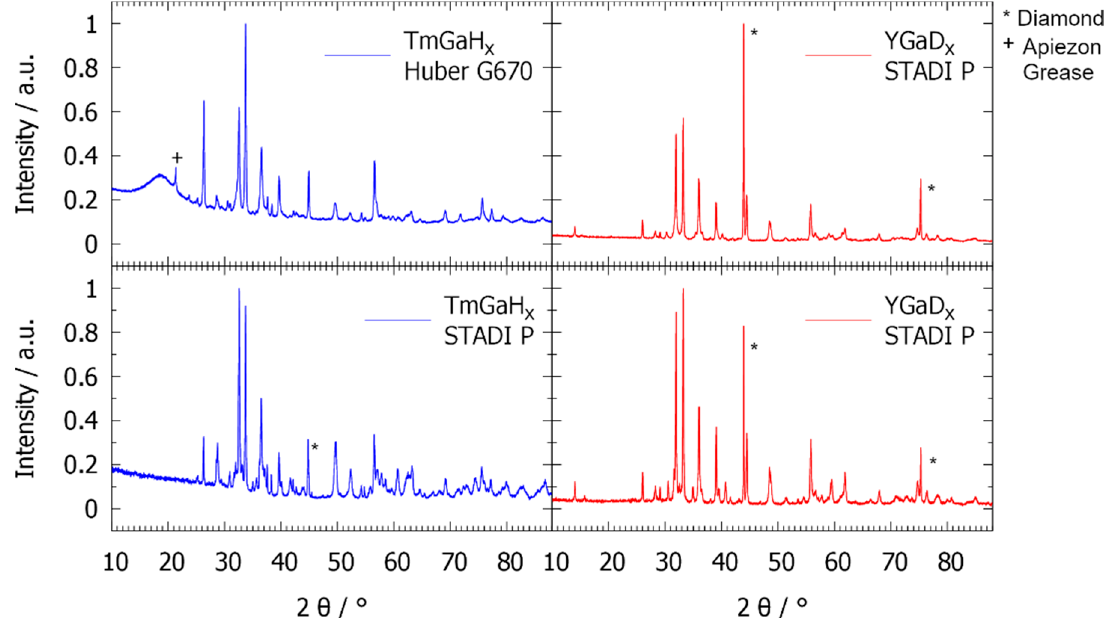
Figure 2. First row : X-ray powder diffraction patterns of TmGaH x and YGaD x after synthesis in the autoclave; second row : X-ray powder diffraction patterns of TmGaH x and YGaD x after storage under argon (glove box) for one week. All patterns were collected with Cu-K α 1 radiation.